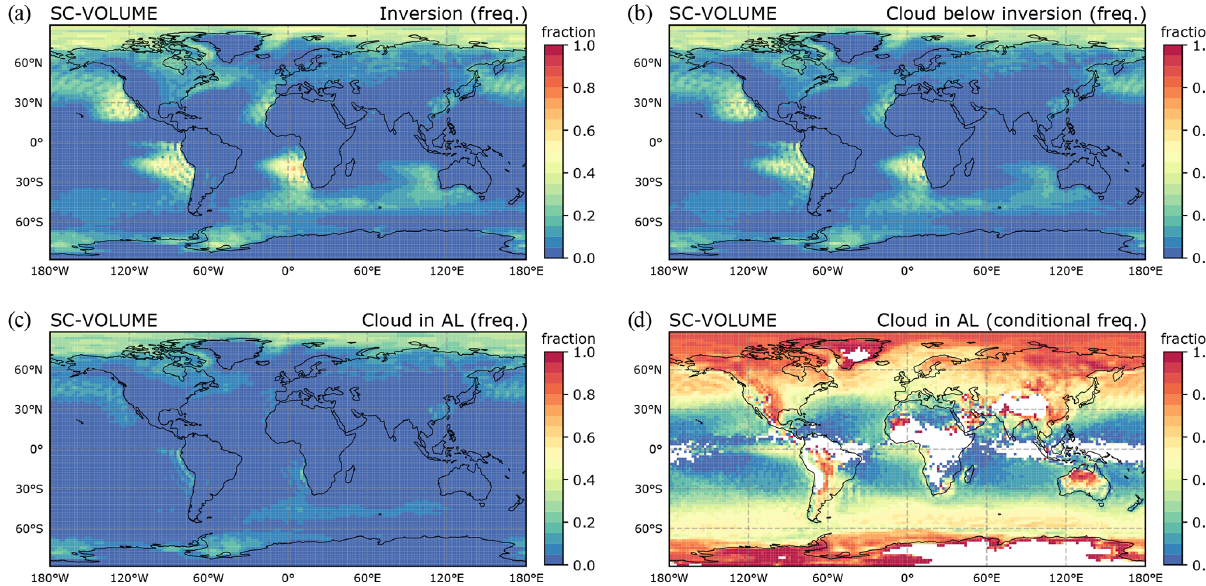
Figure 7. Frequency of occurrence of various conditions related to invgrid in the SC-VOLUME simulation: (a) an inversion is found; (b) a cloud is present below the inversion; (c) a cloud is present in the ambiguous layer; (d) given that there is a cloud below the inversion, the cloud is in the ambiguous layer